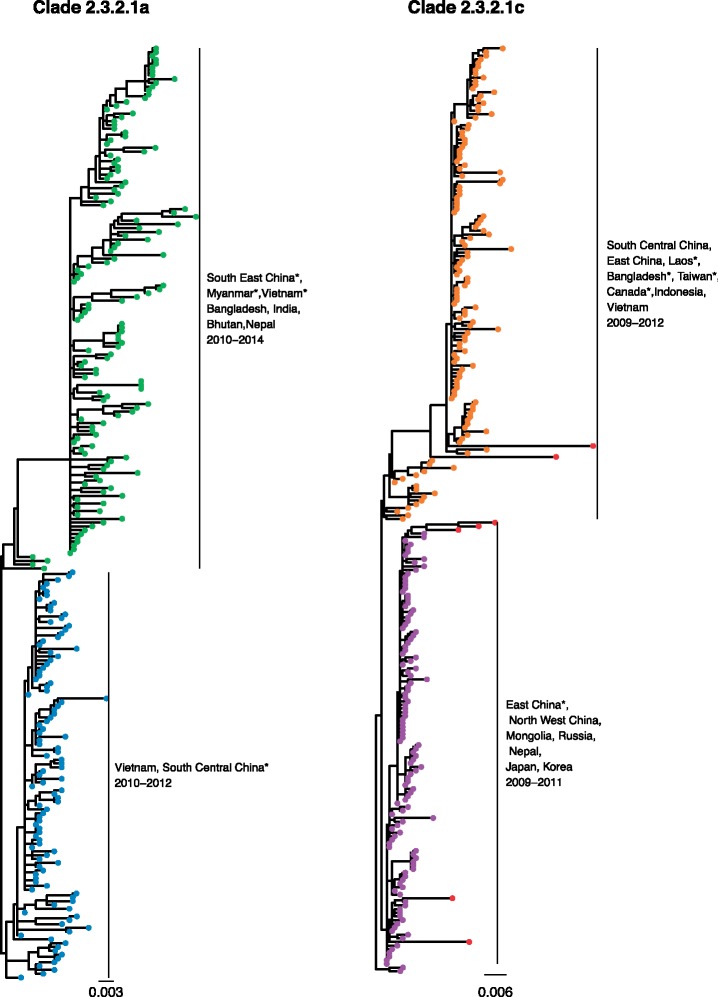
PhyCLIP’s delineation of WHO/OIE/FAO demarcated clades 2.3.2.1a (A) and 2.3.2.1c (B). Tips are colored according to PhyCLIP’s cluster designation. The tips colored in red in B are viruses that were designated as outliers by PhyCLIP’s outlier detection. Countries represented by single viruses in the cluster are indicated with an asterisk.